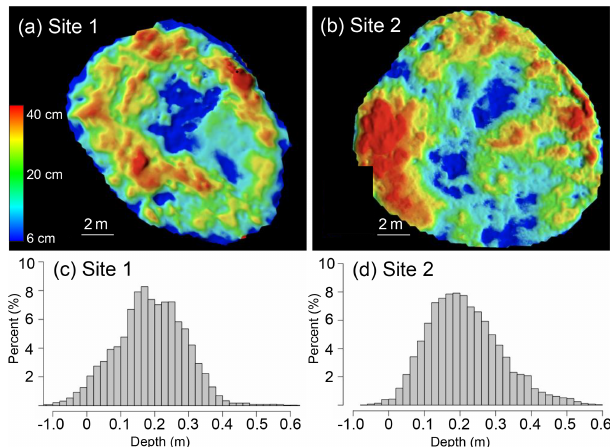
Figure 3. Woodchip thickness distribution maps of pile 1 (a) and pile 2 (b) , with red indicating areas of high thickness and blue indi- cating areas of low thickness. Panel (c) represents the chip thickness histogram for pile 1, and (d) is chip thickness histogram for pile 2. Negative thickness values likely represent snow settling between bare-snow survey and survey after woodchip